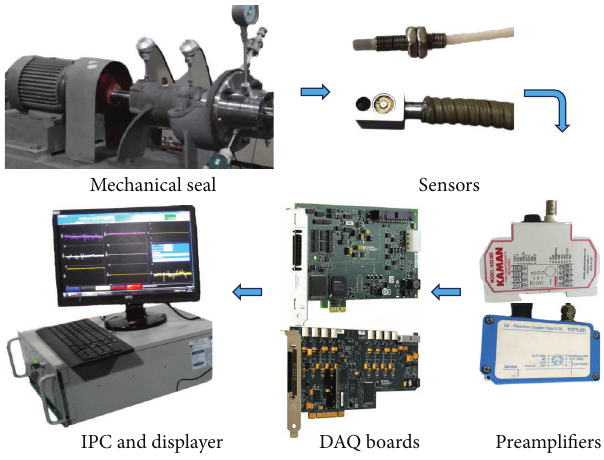
Figure 2: The monitoring